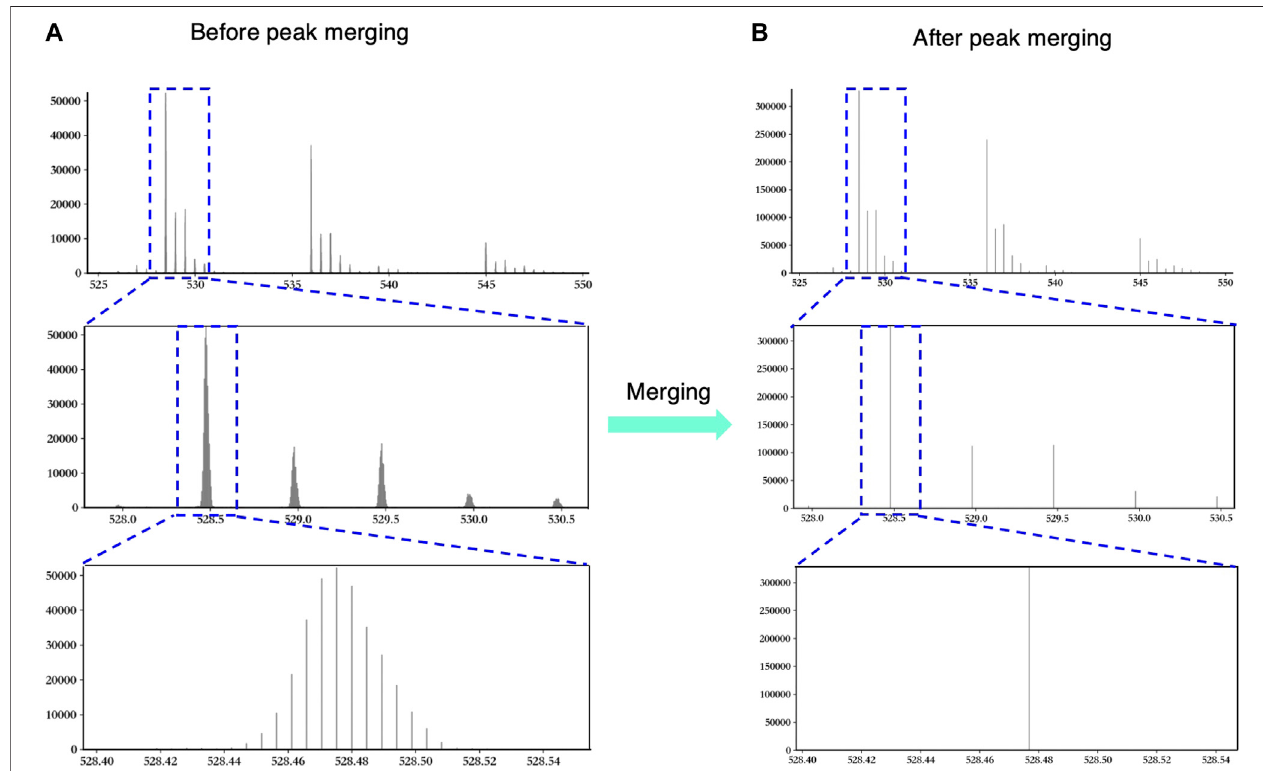
FIGURE2| Anexampletoexplainthenecessityandvalidityofpeakmerging.Theleftthreewindowsshowtheoriginalpeaksbeforepeakmerging (A) ,andtheright three windows show the merged peaks after peak merging (B) . The blue dashed boxes represent the regions that are zoomed in.